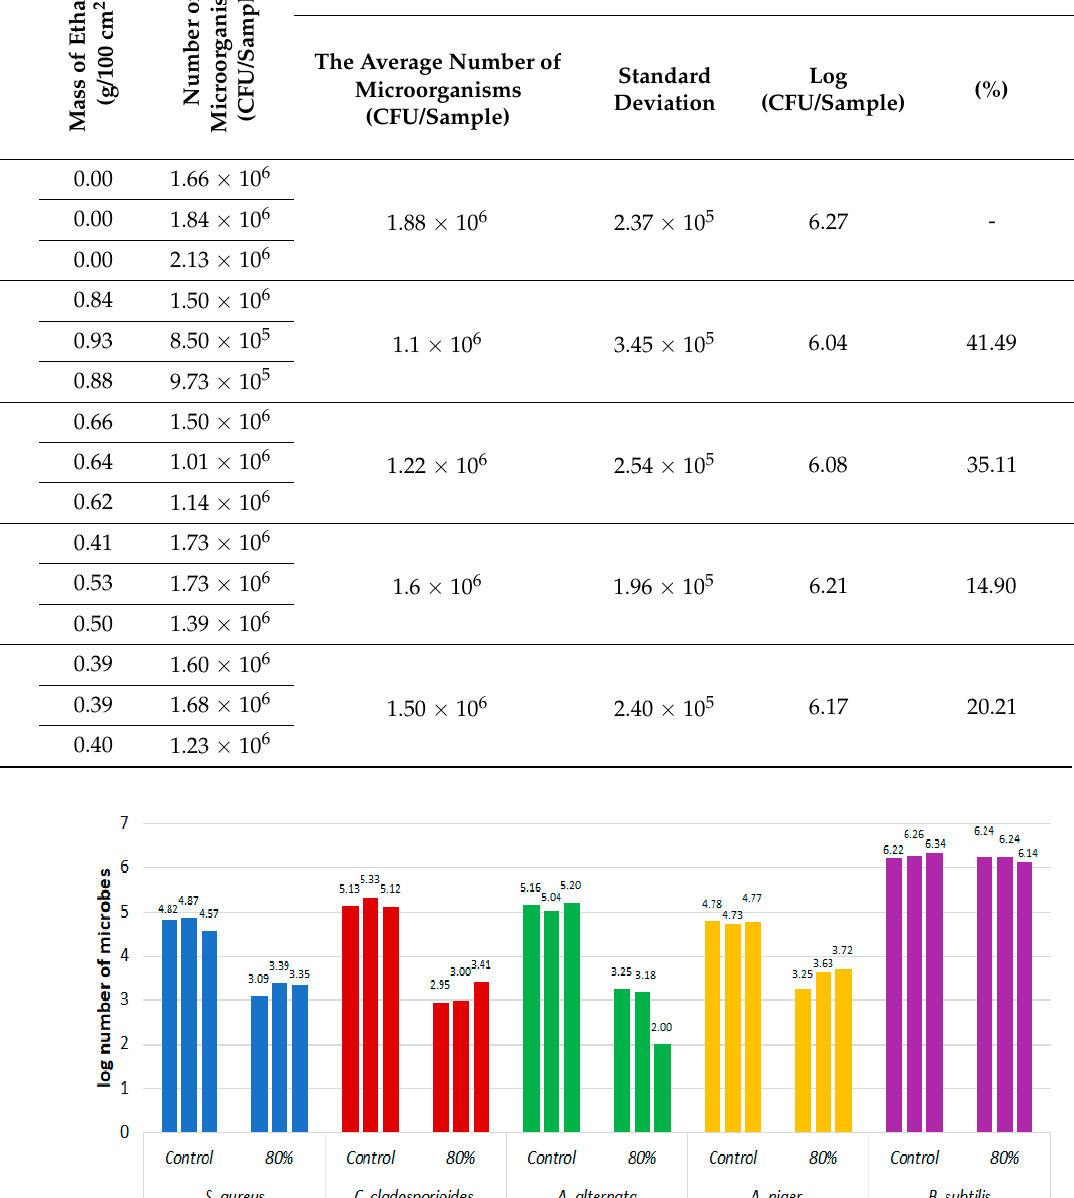
Figure 3. E ff ect of short-term exposure to 90% ethanol in the form of mist on the log decrease in the number of microorganisms on the model fabric compared with the control not treated with the disinfectant. 3.3. The E ff ectiveness of Long-Acting Ethanol In order to further optimize and achieve an increasing reduction in the number of microorganisms, the duration of exposure to ethanol was extended. A similar method but using ethanol vapor in museums to disinfect paper was used [14].